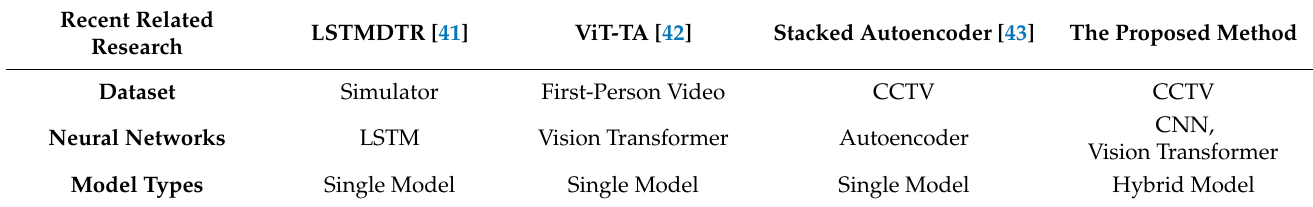
Table 1. Differences between recent accident classification models and the proposed method.